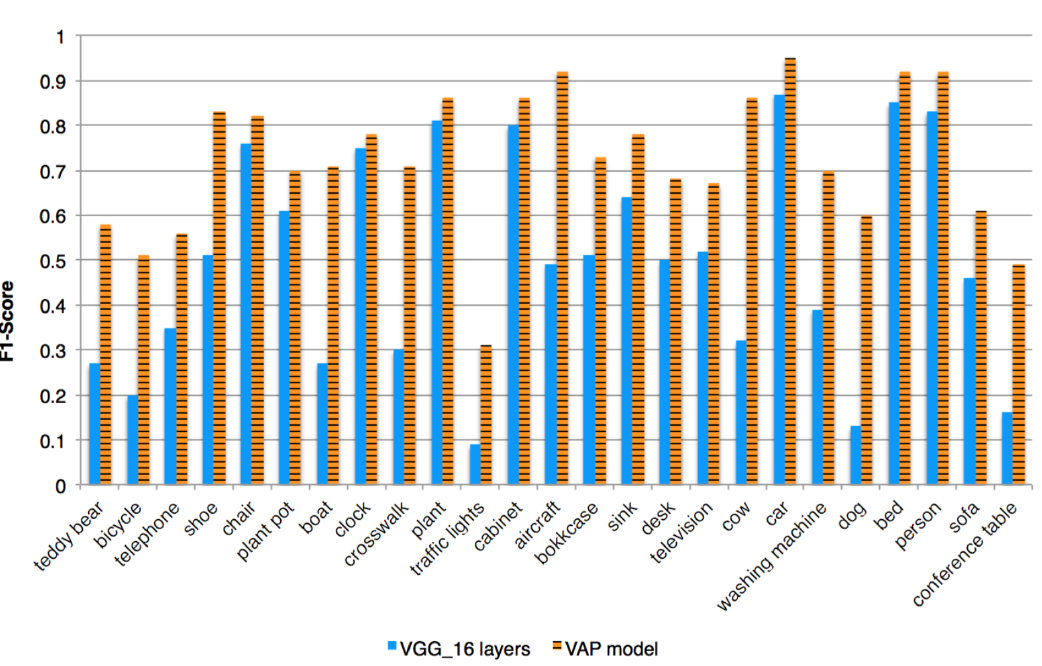
Figure 8. Comparison for all classes using the complete VAP model and using only the bottom-up pathway